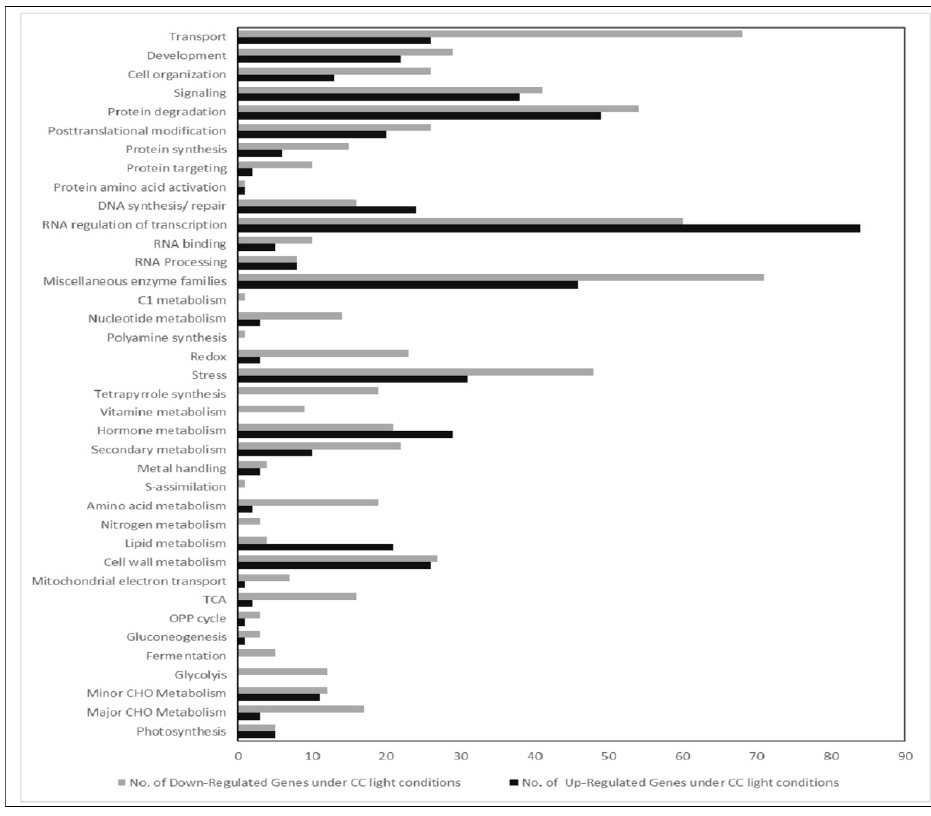
Figure 3. Comparative gene expression analysis of RNA isolated from plants grown in LED100, climate chamber. Bar chart of up (black bars) and down (grey bars) regulated genes from plants grown in the climate chamber.